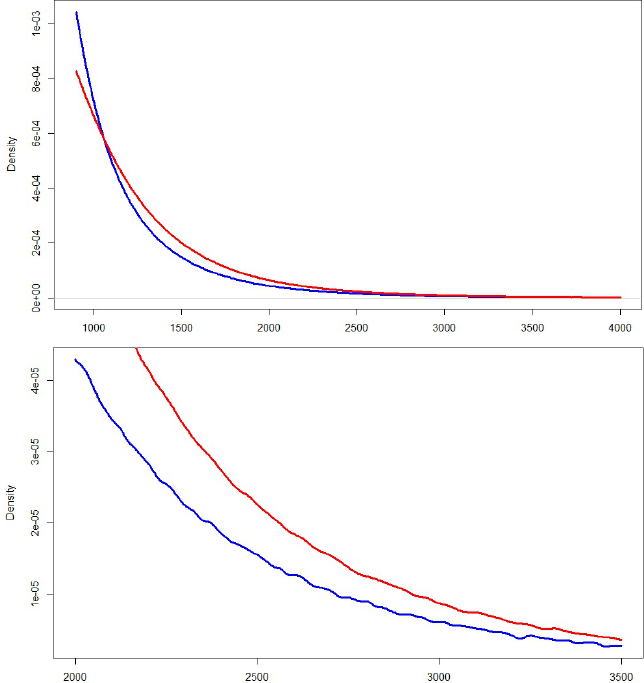
Figure 5. Illustration of the impact of the permutation on the loss distribution, with a focus on the right on the area around the capital requirement (99.5